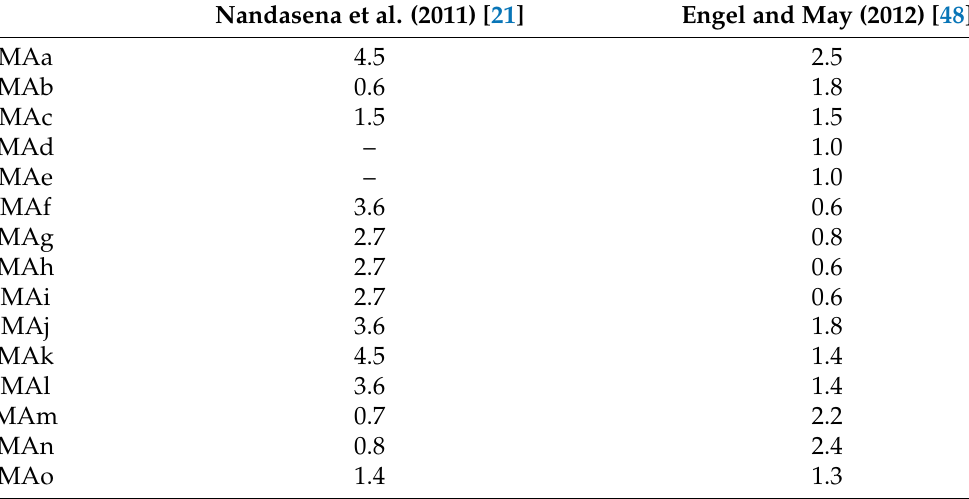
Table A21. Minimum wave heights H m (m) required to displace the boulders of the Mancaversa